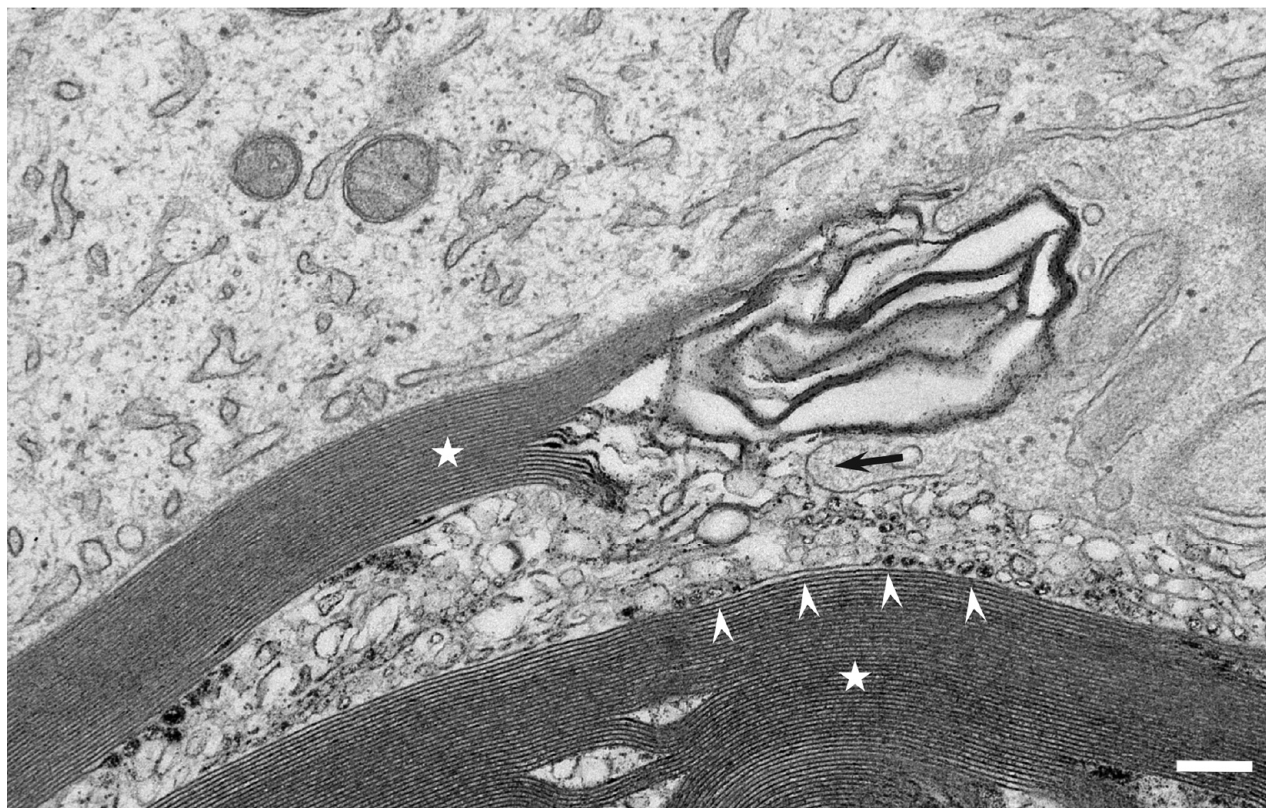
Figure 4. Vesicular dissolution of myelin. A cross section of a sural nerve biopsy specimen obtained from a patient with AIDP. Vesicular dissolution of the myelin is seen in a space between the myelin lamellae indicated by asterisks. Vesicles seem to be formed by the separation of the major dense lines (arrowheads). A process of macrophage indicated by an arrow seems to be invading a gap created by the dissolution of myelin lamellae. Uranyl acetate and lead citrate staining. Scale bar = 0.2 m.